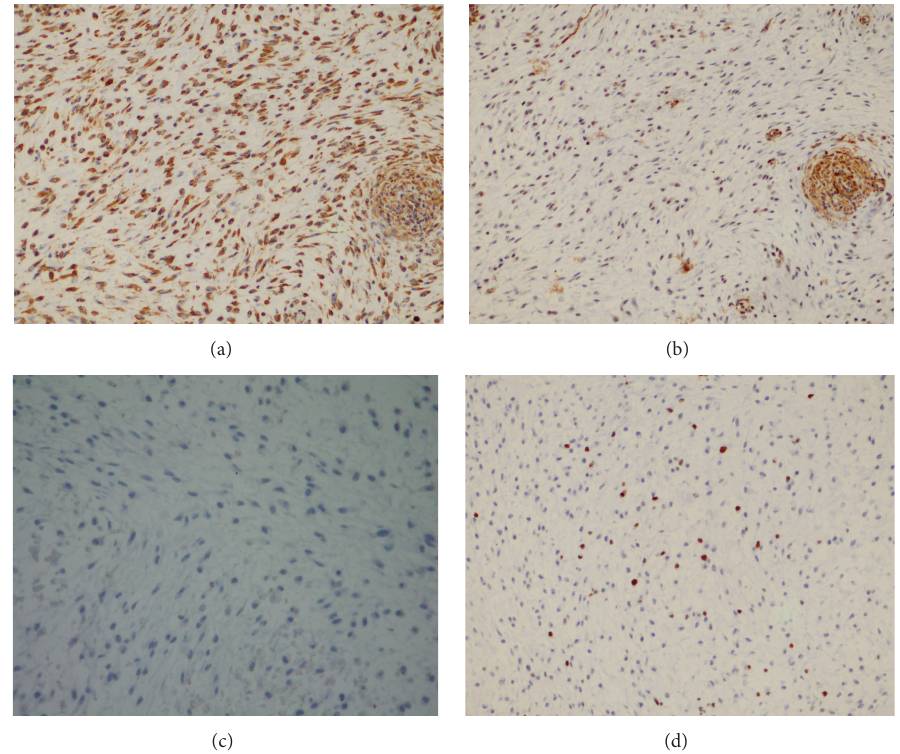
Figure 5: Immunohistochemical analysis: (a) diffuse positivity for vimentin, (b) focal expression for 1A4 auto control: vessels wall, (c) AE1- AE3 negative, and (d) Ki-67 expression around 5–8% of the